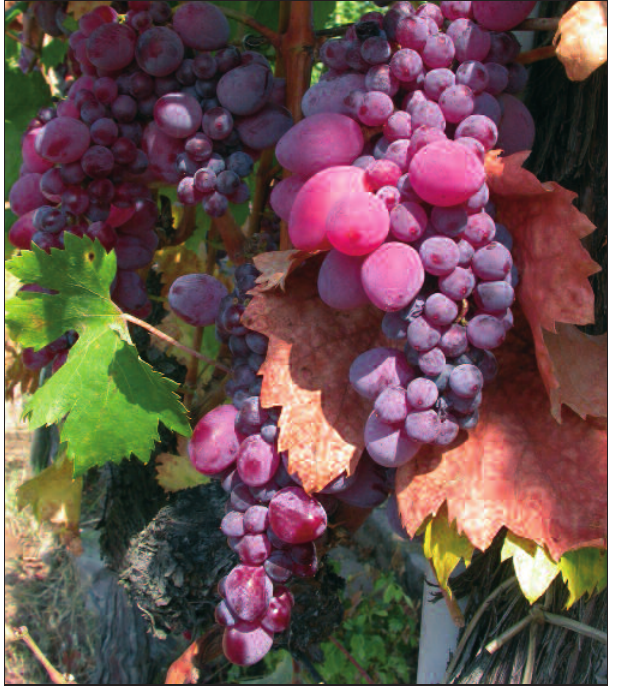
Fig. 3. Millerandage on clusters